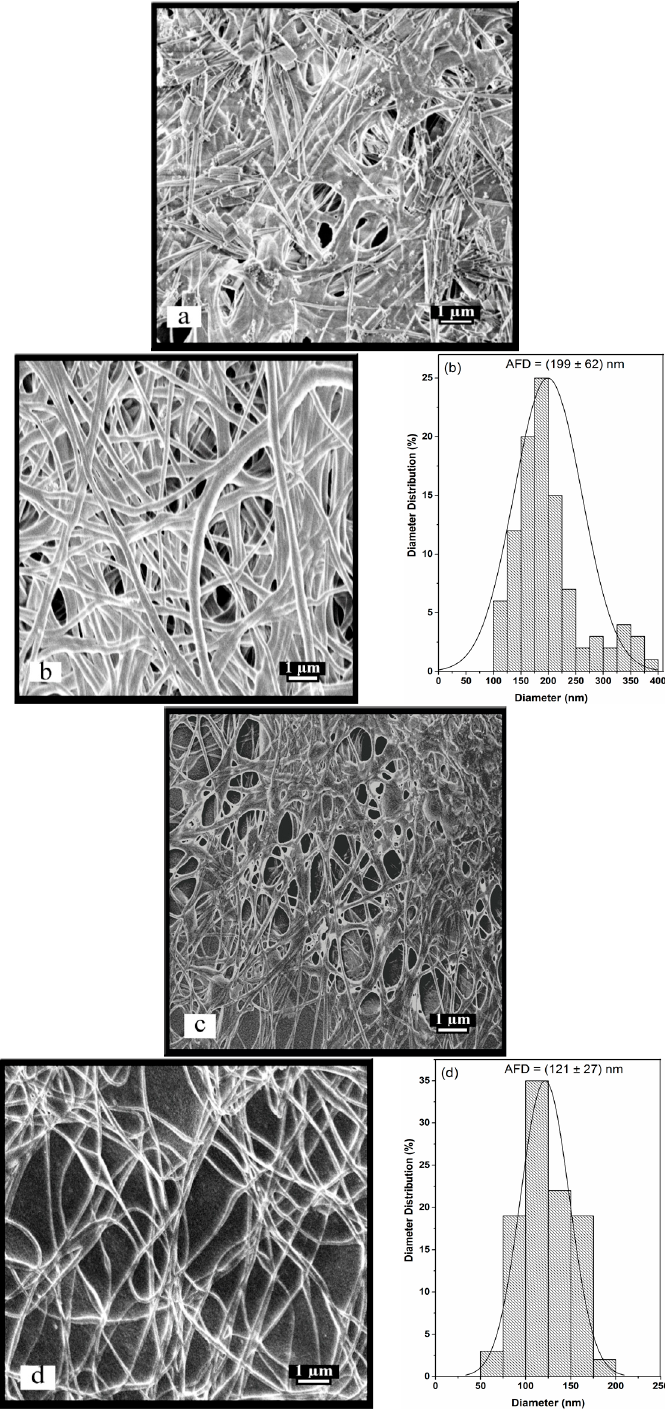
Figure 4. The SEM images of the membrane surface of chitosan/PEO at different ratios. ( a ) 60/40 neutralized in water; ( b ) 60/40 neutralized in ethanol/water mixture; ( c ) 80/20 neutralized in water; and ( d ) 80/20 neutralized in ethanol/water mixture.